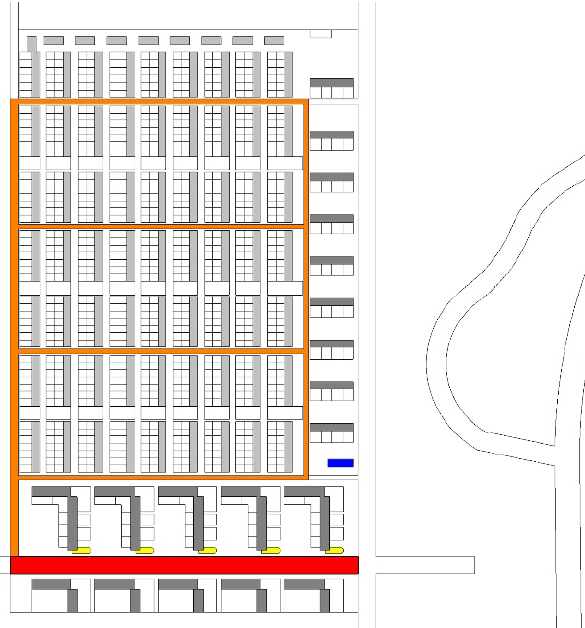
Figure 25. Formal structure, Siedlung Westhausen. Drawing by Manlio Michieletto.